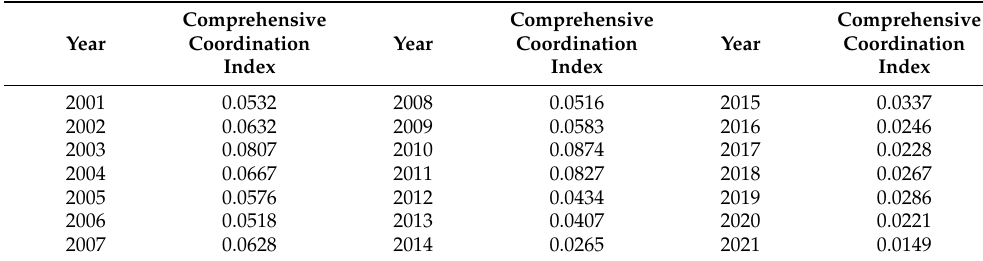
Table 6. The comprehensive coordination index V j .